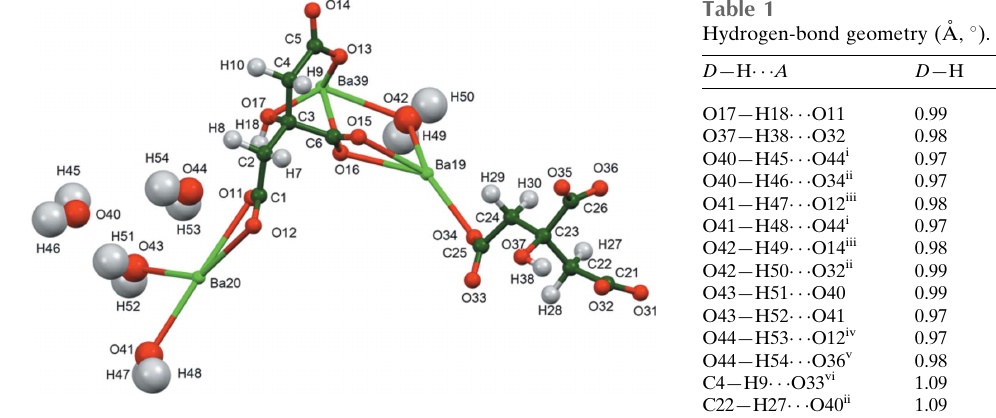
Figure 1 The asymmetric unit of (I) with the atom numbering and 50% probability spheres.